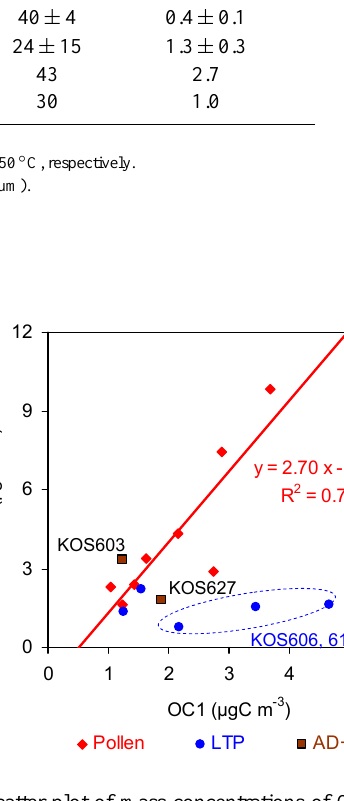
Fig. 12. Scatter plot of mass concentrations of OC1 versus OC2. The pollen, LTP, and AD+LTP episodes are shown as filled red di- amond, blue circle, and brown rectangular, respectively. OC1 and OC2 represent organic carbons evolved at 300 ◦ C and 450 ◦ C, re-